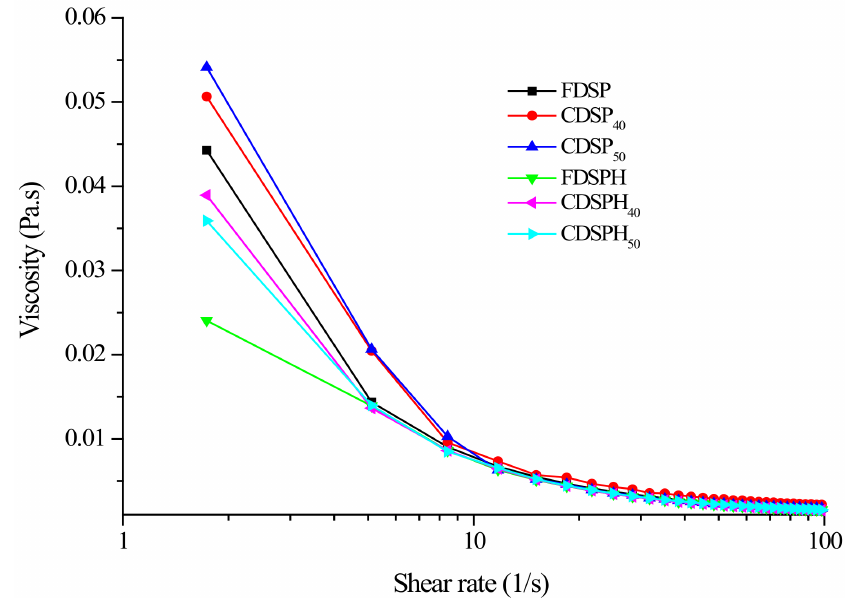
Figure 4. Apparent viscosity of freeze- and convectively-dried SP and SPH.